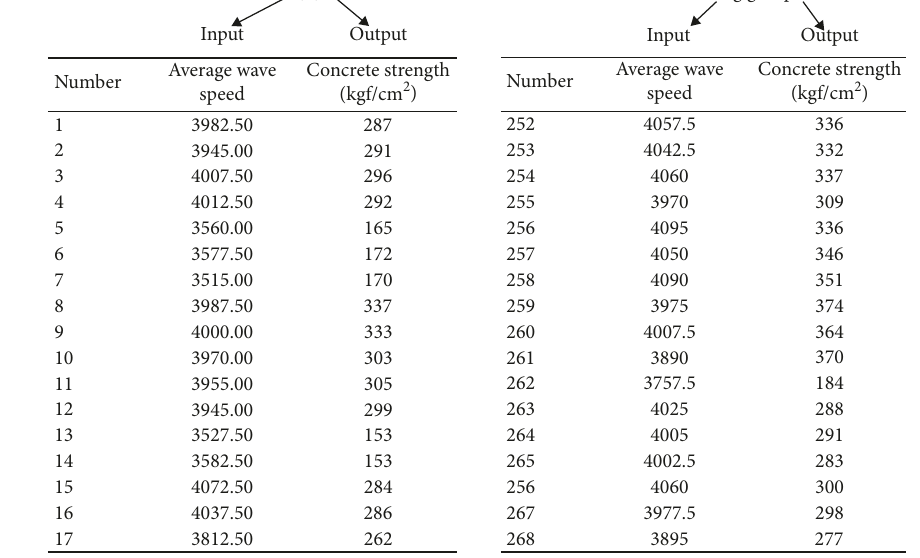
Figure 7: ANNs model data collection process.